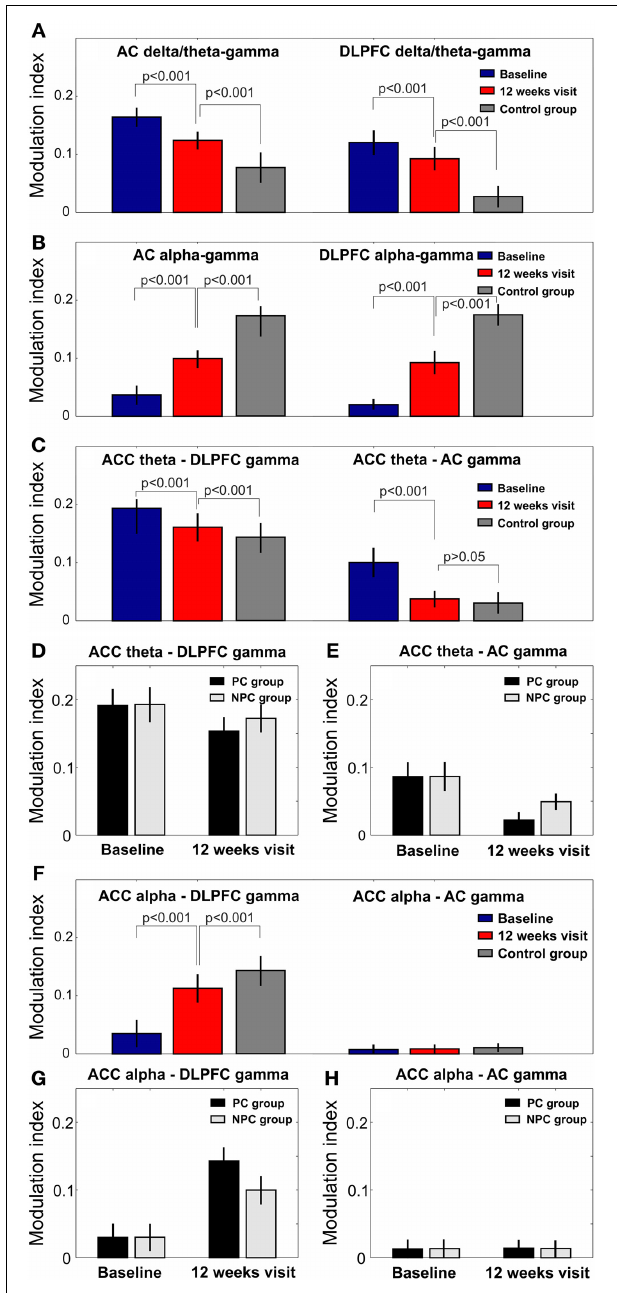
FIGURE 2 | The modulation index values in all n = 32 investigated patients at baseline and at the 12 weeks visit. The gamma amplitude delta/theta phase modulation index in the AC and DLPFC (A) . The gamma amplitude alpha phase modulation index in the AC and DLPFC (B) . After 12 weeks of acoustic CR neuromodulation the CFC between delta/theta phase and gamma amplitude approached the CFC in the healthy control group (A,B) . CFC between ACC theta phase and DLPFC/AC gamma amplitude (C) . The modulation index values for CFC between ACC theta phase and DLPFC/AC gamma amplitude in both PC ( n = 16) and NPC ( n = 16) groups at baseline and at 12 weeks visit (D,E) . The reduction of CFC between ACC theta phase and DLPFC/AC gamma amplitude was significantly more pronounced in the PC group than in the NPC group at 12 weeks